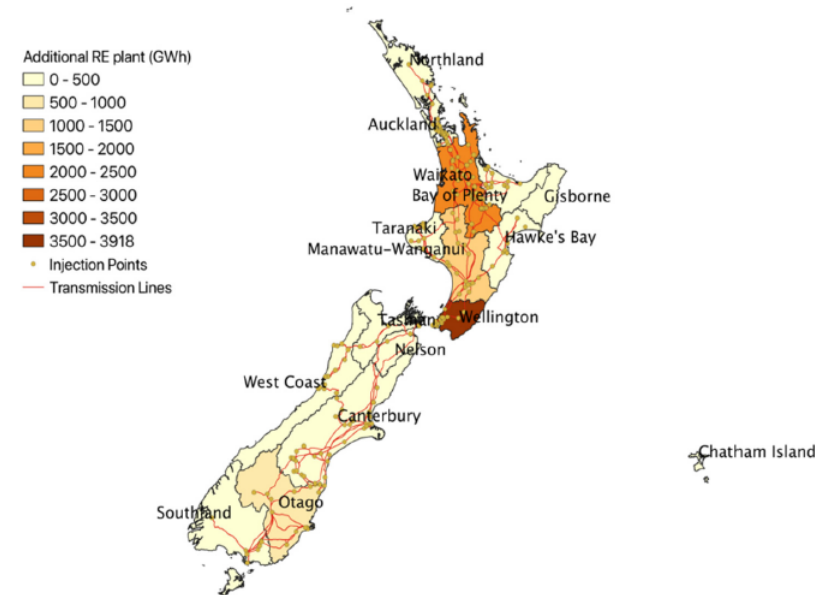
Figure 4. Regional distribution of additional